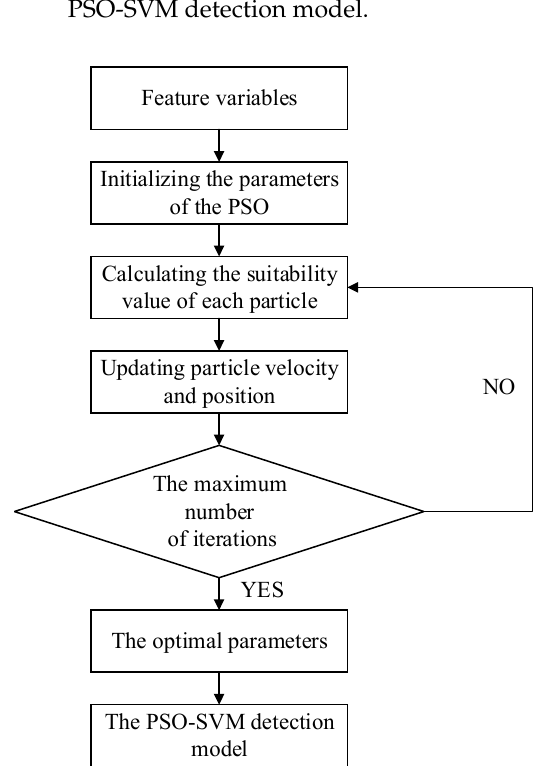
Figure 4. Flowchart of particle swarm optimized support vector machine detection model.